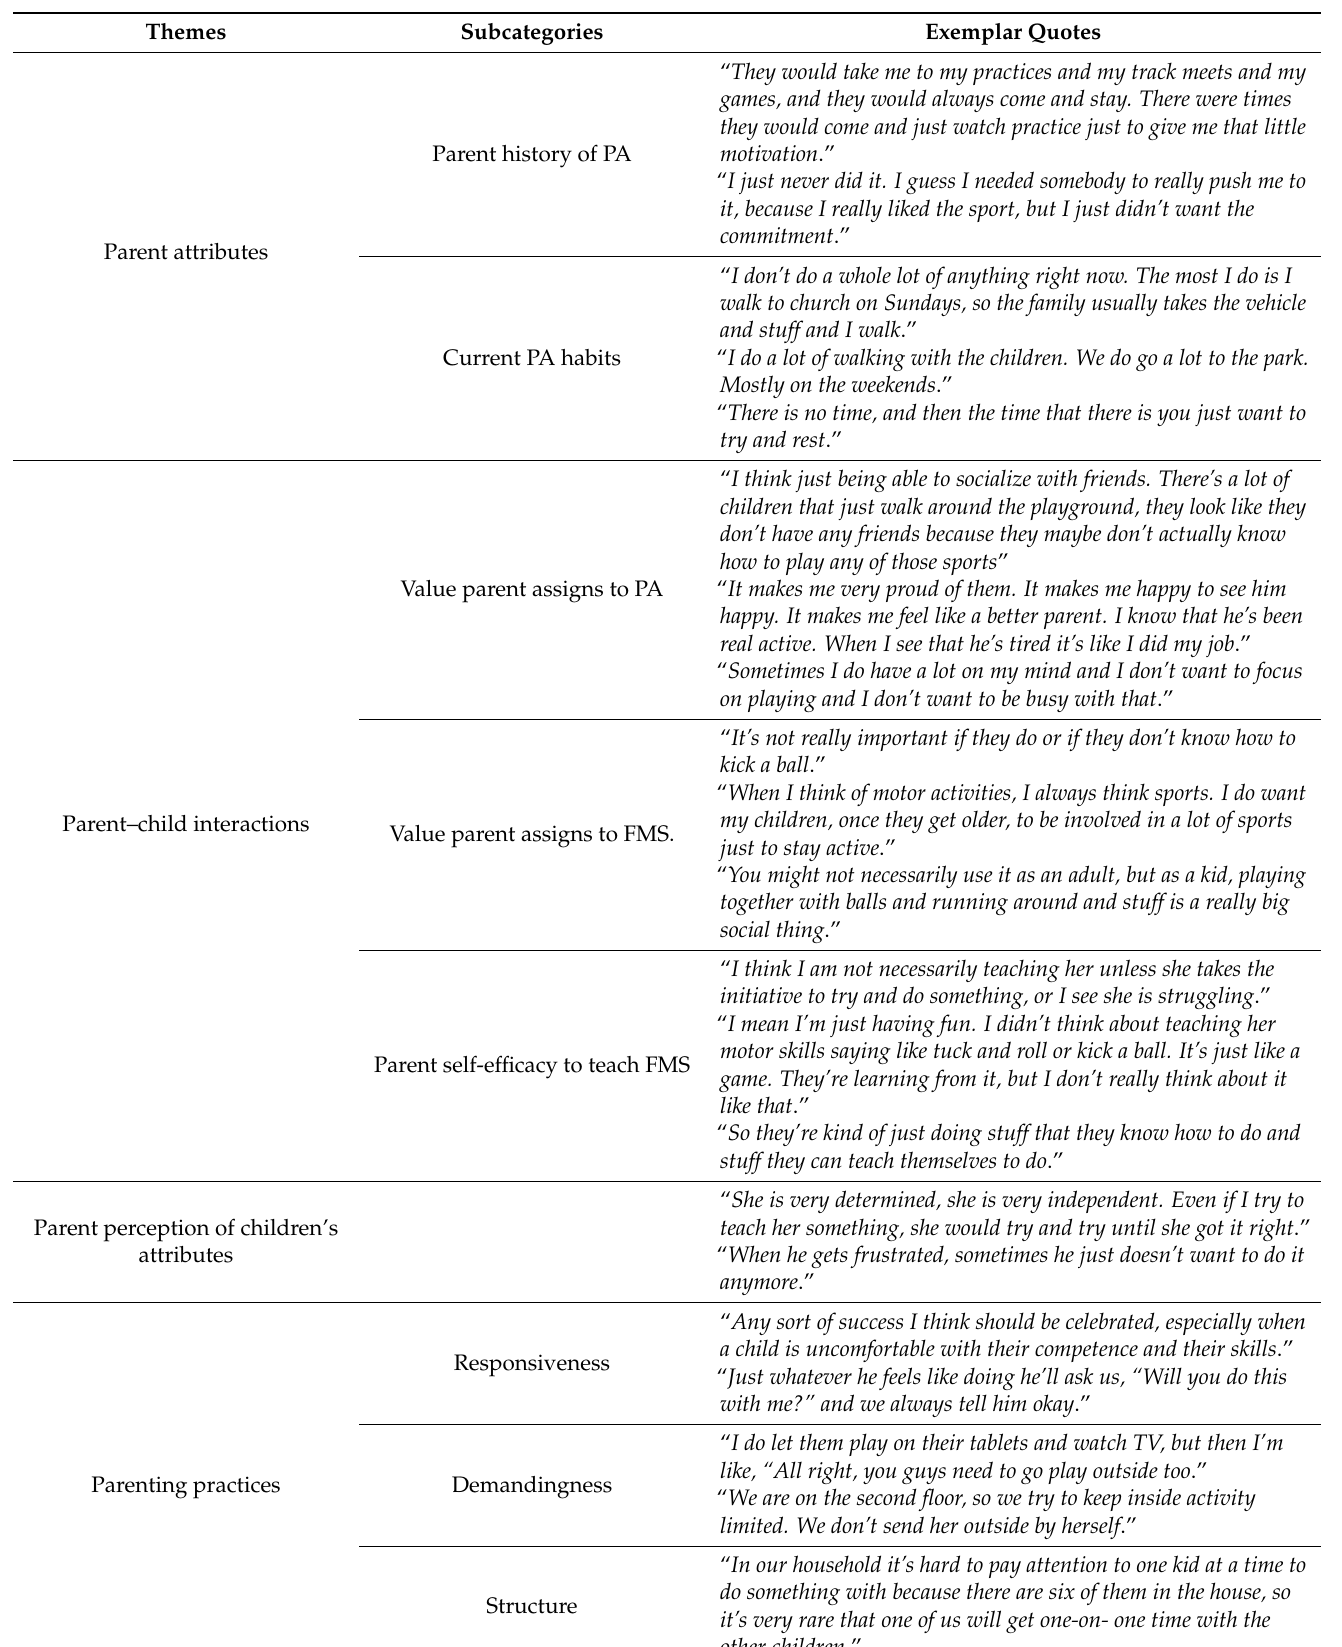
Table 2. Themes and participant exemplar quotes related to physical activity and fundamental motor skills of